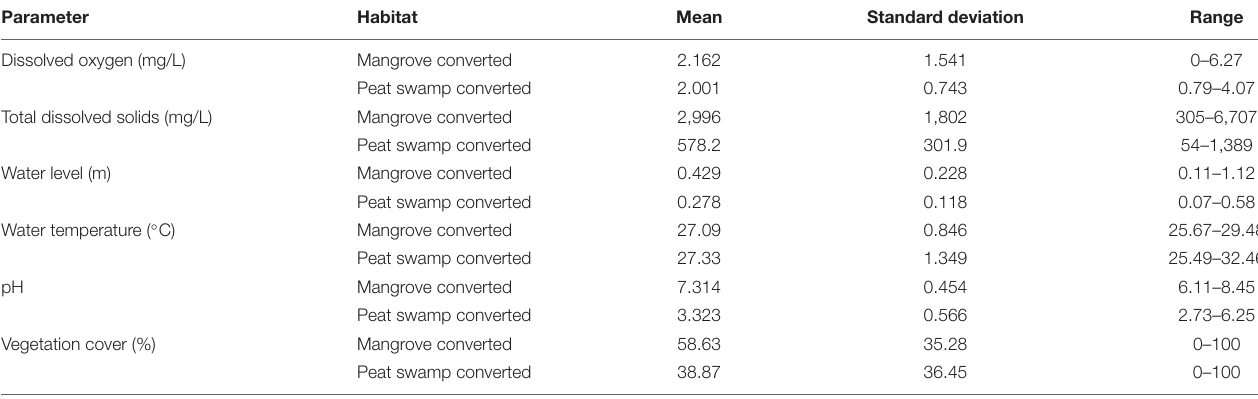
TABLE 1 | Summary statistics for water quality and vegetation parameters. Parameter Habitat Mean Standard deviation Range Dissolved oxygen